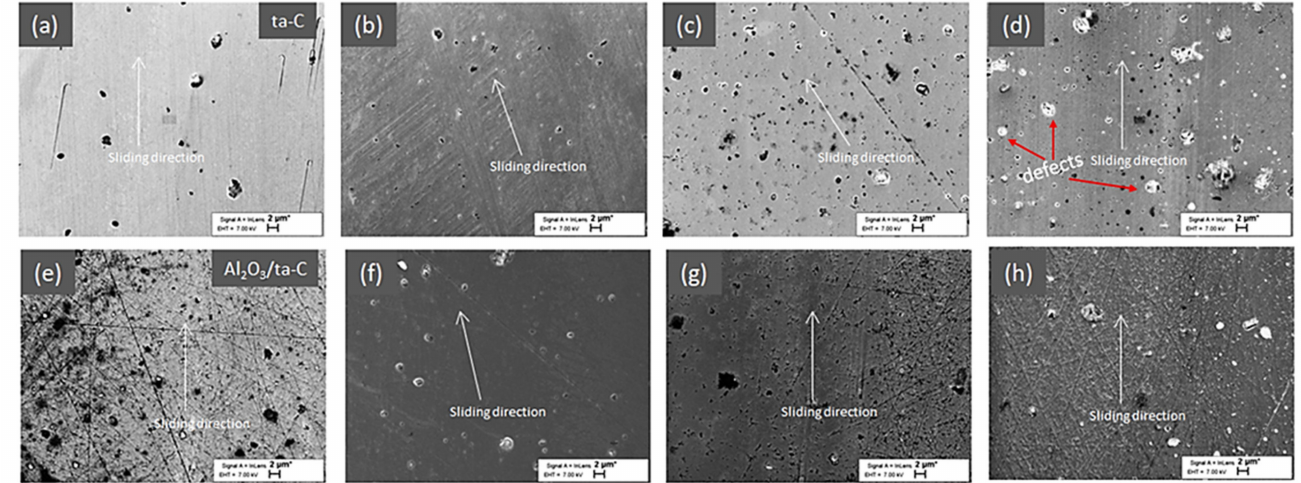
Figure 5. SEM images of the wear scars after tribological tests for 10 min at ( a , e ) RT, ( b , f ) 400 ◦ C, ( c , g ) 450 ◦ C and ( d , h ) 500 ◦ C on both types of coatings.